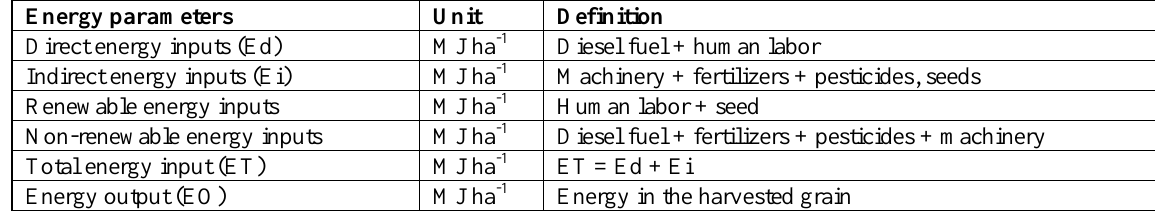
Table 2. Energy parameters and their definitions Energy parameters